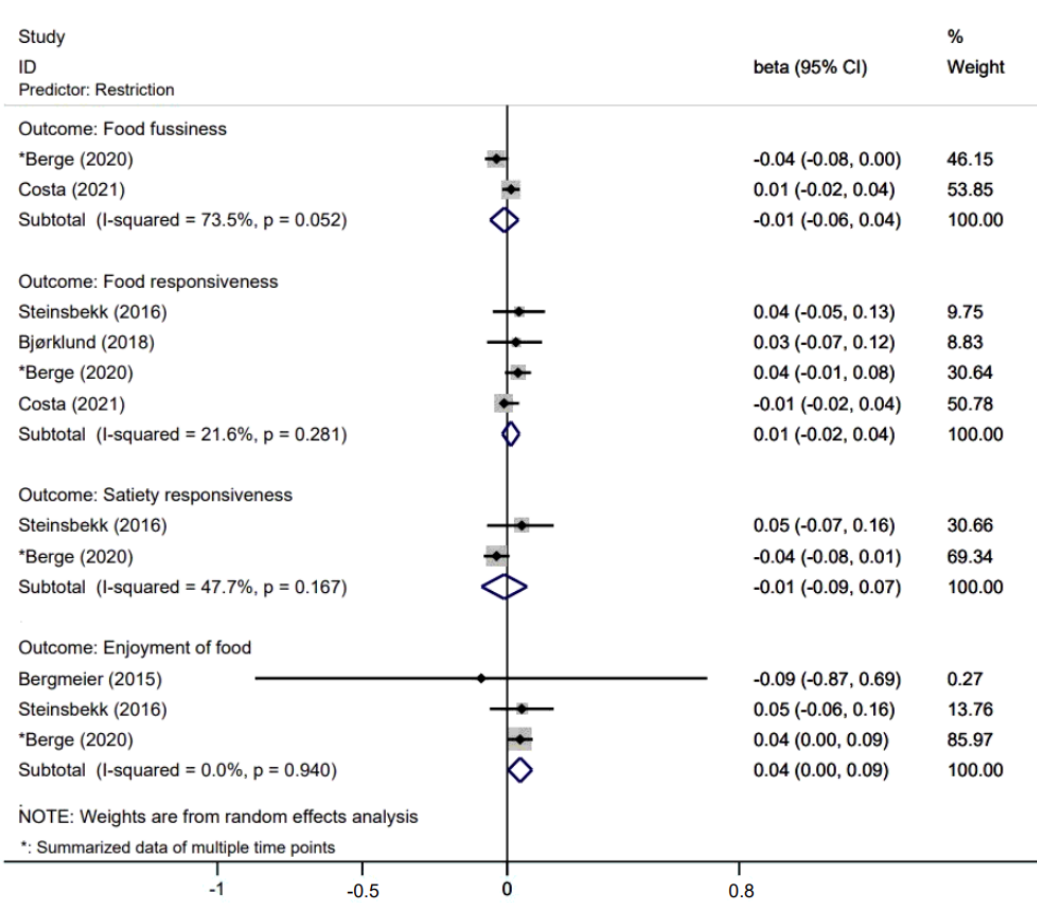
Figure 2. Effects of parental restriction on child eating behaviors.